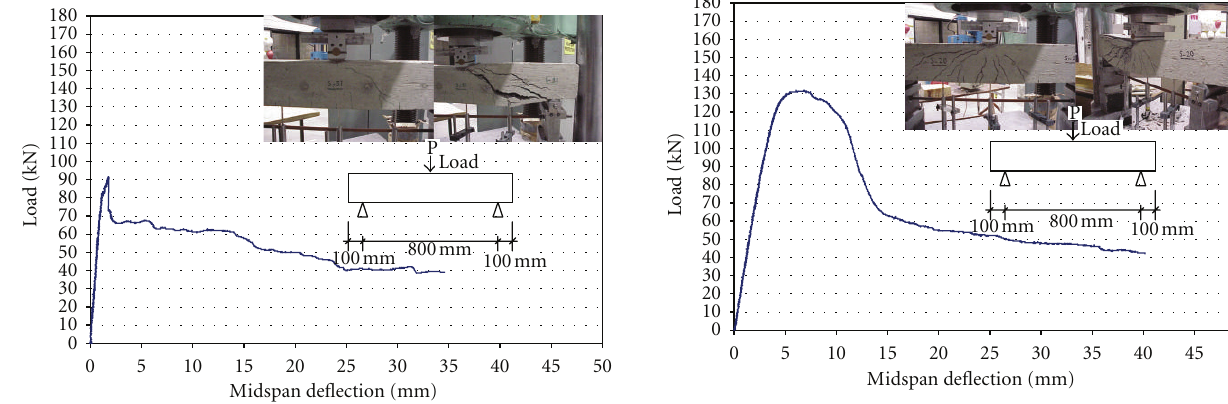
Figure 4: Load versus midspan deflection of control RC beam C-S-1.